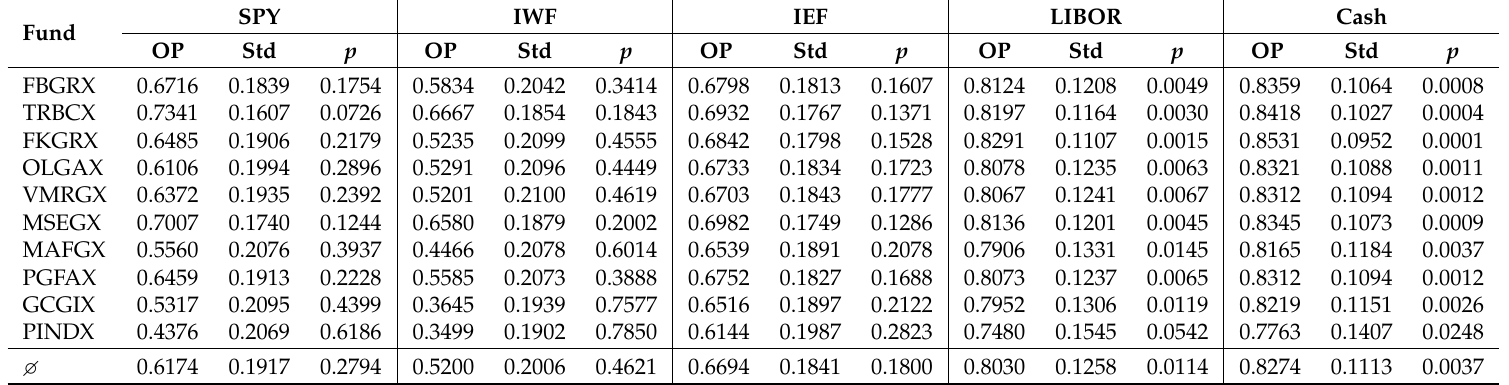
Table 6. Results in the case that T is uniformly distributed between 0 and 10